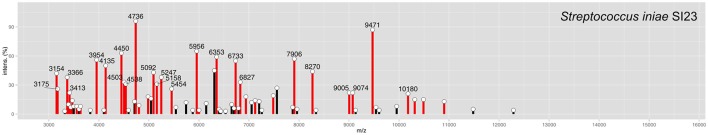
MSP of S. iniae SI23 peak identification. Peaks with intensities greater than 20% are labeled. Peaks with a previously identified m/z (Kim et al., 2017) are shown in red bars.